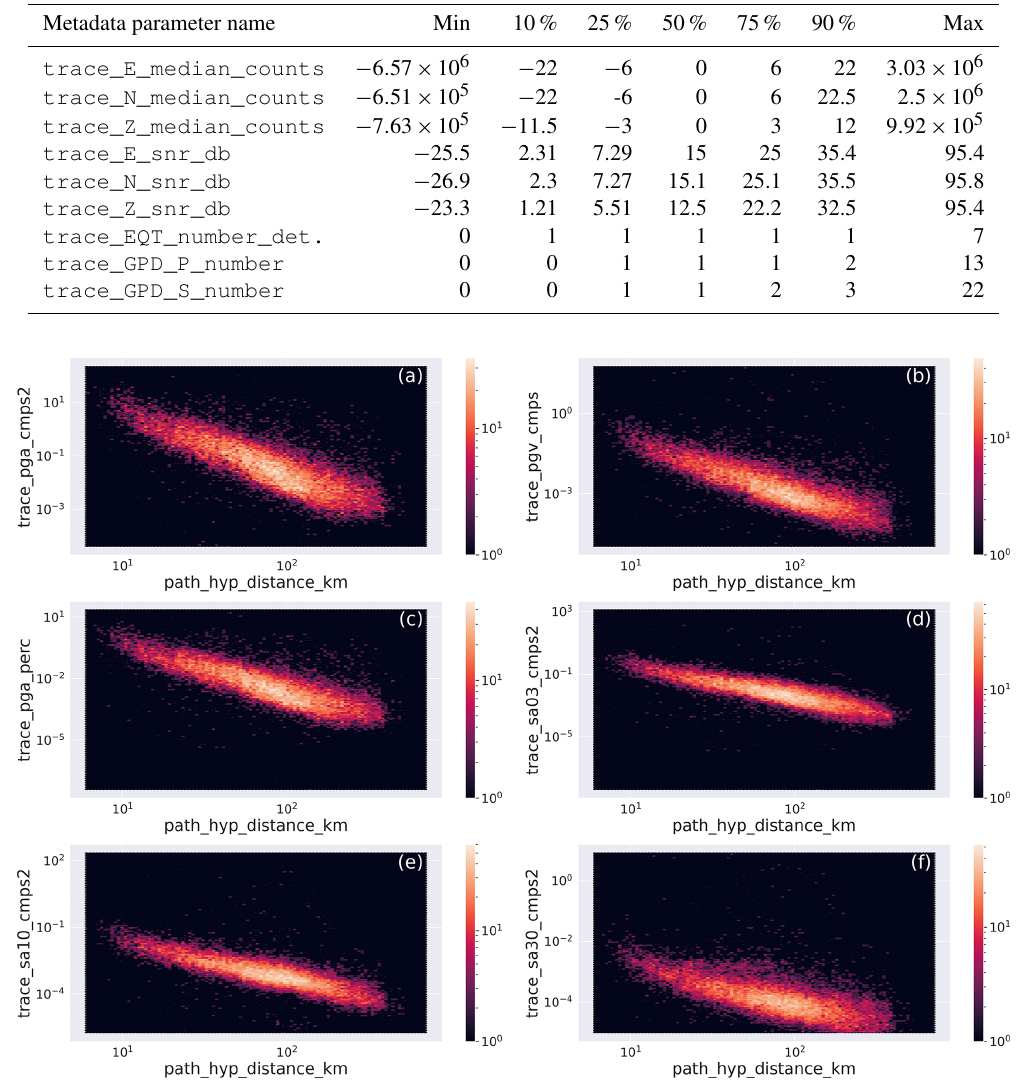
Figure 13. Hexbin plot of the distribution of the intensity measures (IMs) with hypocentral distance for M = 3 earthquakes. The units are kilometers (km) along the horizontal axis in all panels, and along the vertical axis the units are centimeters per second squared (cms − 2 ) in panels (a) and (d) – (f) , centimeters per second (cms − 1 ) in panel (b) , and percent of the acceleration of gravity (% g ) in panel (c) .